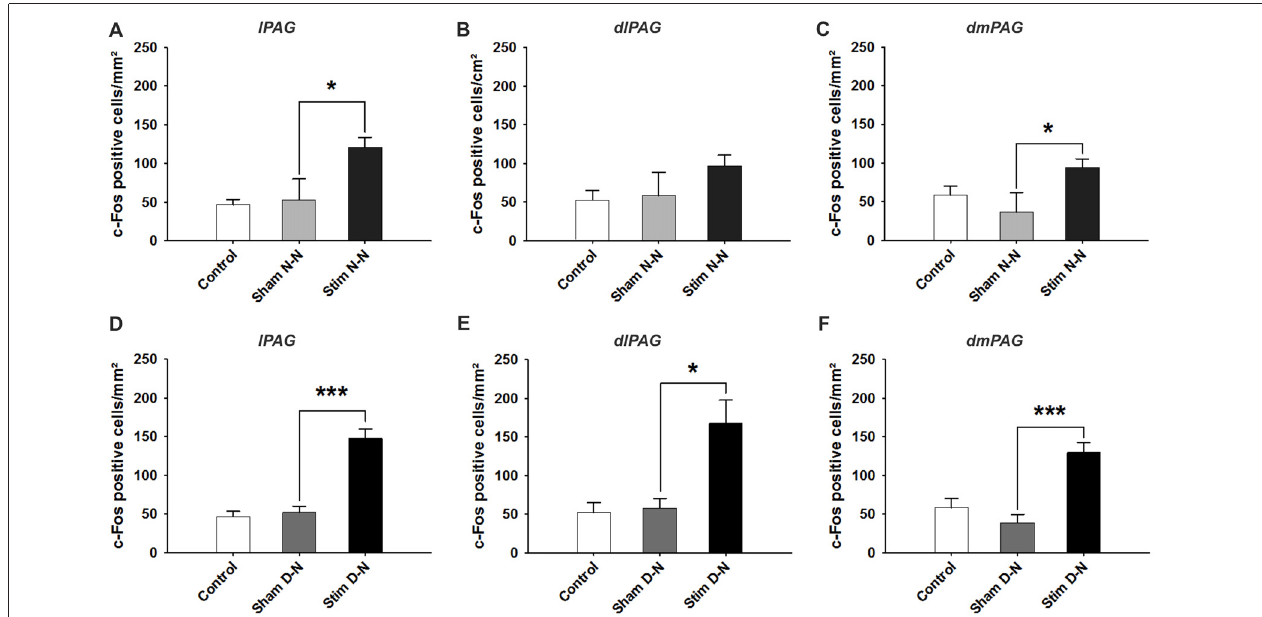
FIGURE 3 | Expression of cFos immunoreactive cells in the rostral periaqueductal gray matter (PAG). Cumulative data showing the means and SEM. of cFos expression for N-N group in the rostral (A) lPAG, (B) dlPAG, (C) dmPAG and for D-N group in the rostral (D) lPAG, (E) dlPAG, (F) dmPAG. Control n = 12, Sham N-N n = 12, Sham D-N n = 12, Stim N-N n = 14 and Stim D-N n = 14. t -test, ∗ p < 0.05 and ∗∗∗ p < 0.001.